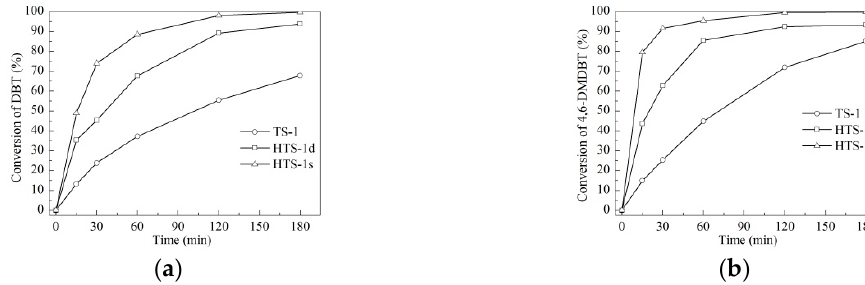
Figure 4. Catalytic oxidation of dibenzothiophene (DBT) ( a ) and 4,6-dimethyldibenzothiophene (4,6-DMDBT) ( b ) over TS-1, HTS-1d, and HTS-1s.